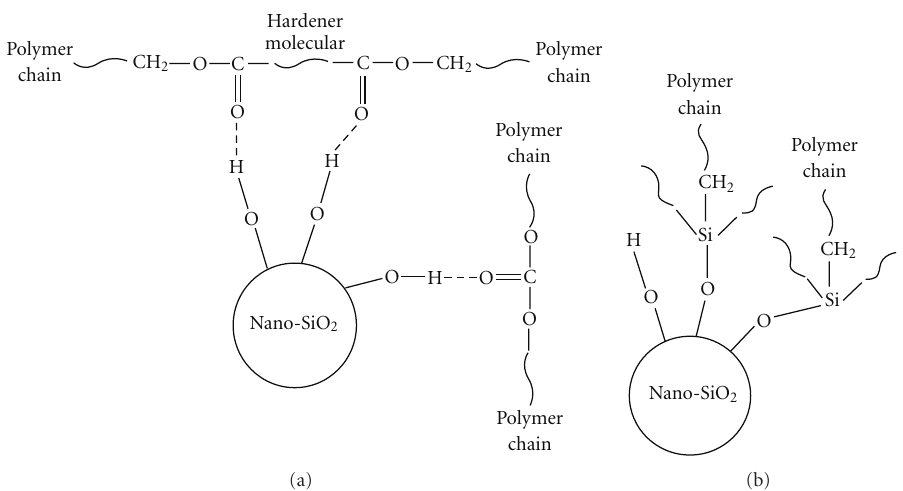
Figure 11: Cross-link structure built by nanoparticle in polymer chain (a) crosslinked by physical absorption (H-bond) (b) crosslinked by chemical bond (Coupling agent).